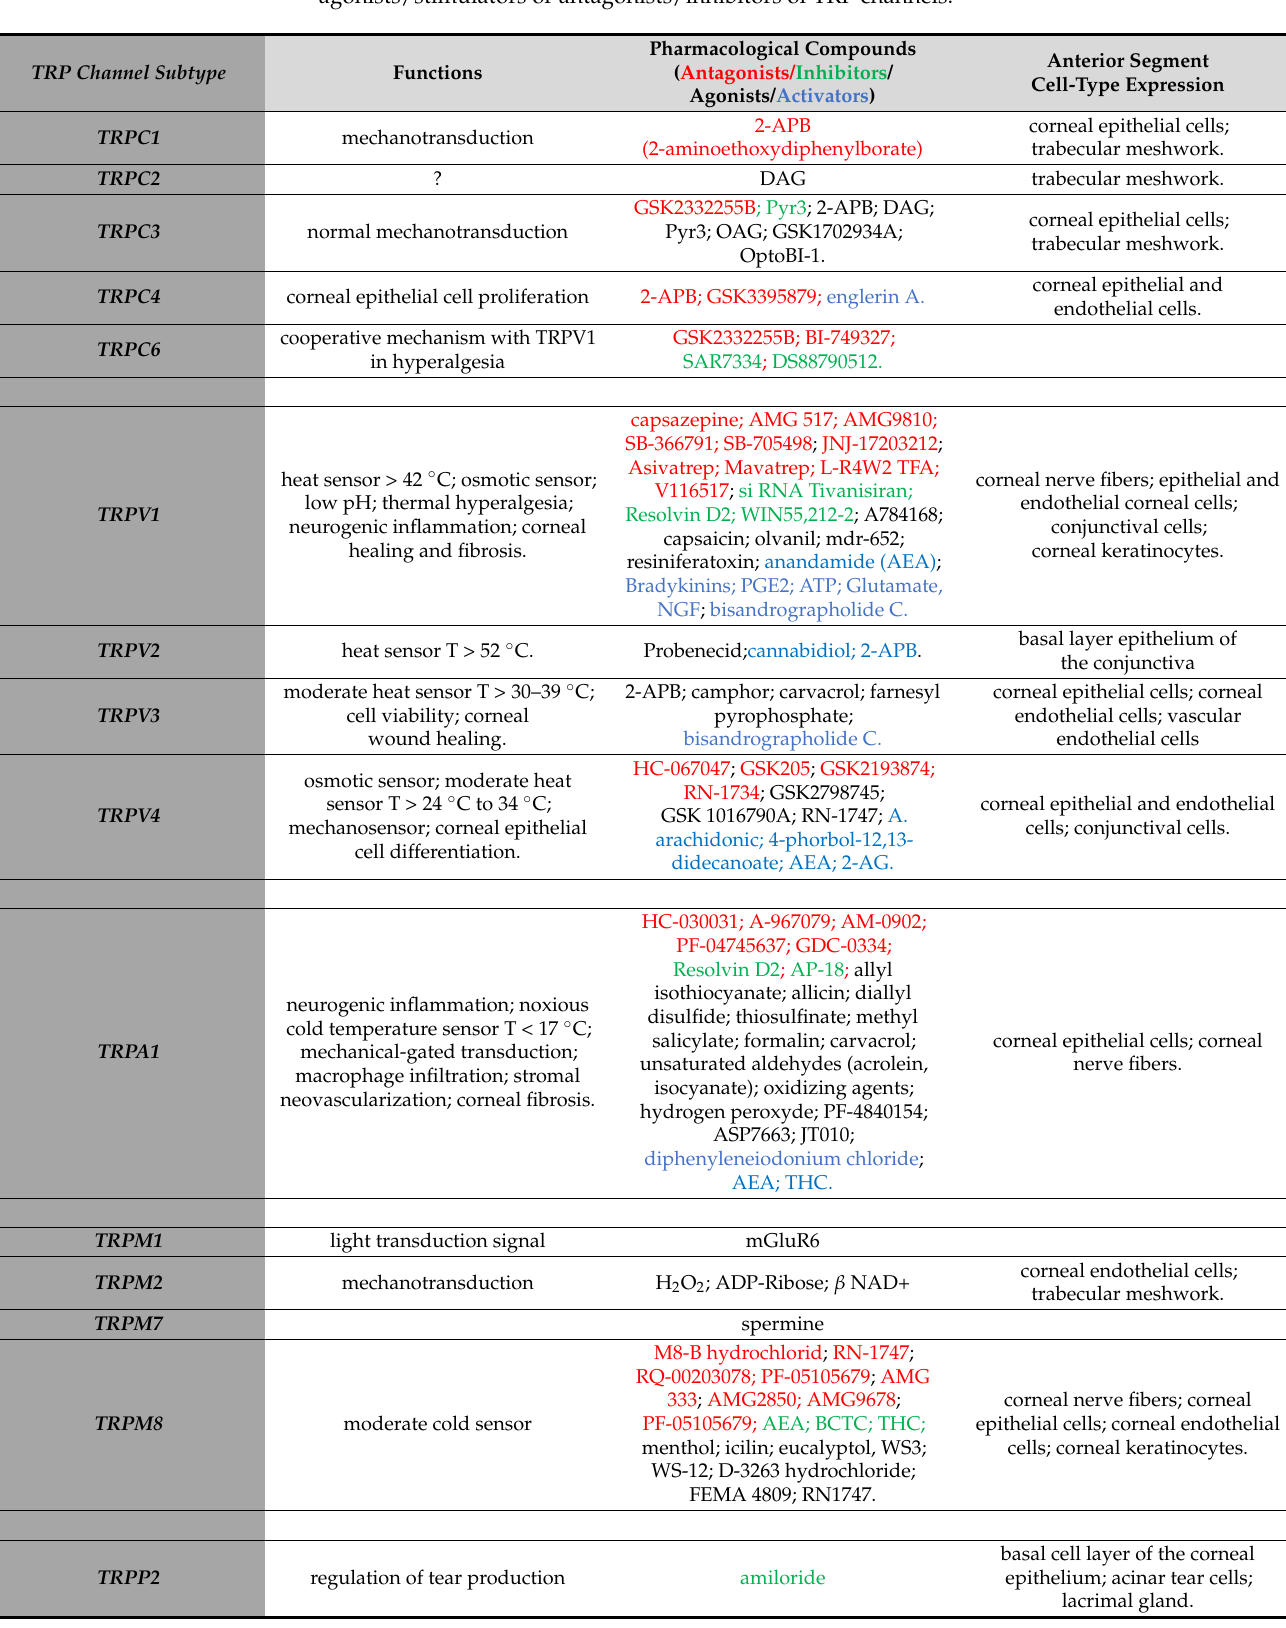
Table 1. Functions and localization of TRP channels in the anterior segment of the eye. Respective agonists/stimulators or antagonists/inhibitors of TRP